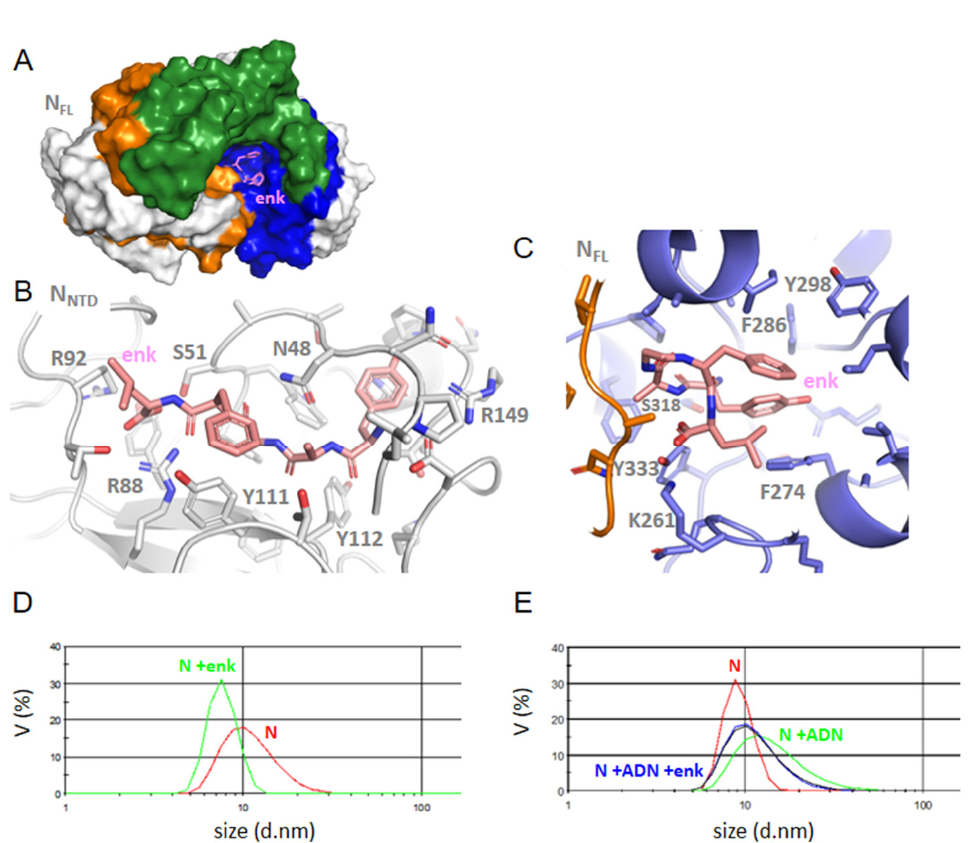
Figure 6. Interactions of Leu-enkephalin with NTD or FL. ( A ) enkephalin binding in CTD site in N FLwt, ( B ) the zoom of NTD-enkephalin complex, ( C ) FL-enkephalin complex; note the multiple hydrophobic interactions of this ligand in FL with P274, F286, Y298 and Y333, while the aromatic residues of the NTD β -sheet are involved in ligand binding in the NTD; ( D ) size distribution of N and its complex with enkephalin, which decreased its size as compared to the size of N alone; ( E ) the size of the N-DNA complex was reduced upon addition of enkephalin, in agreement with a competition of the ligand with nucleic acid binding to N FL.